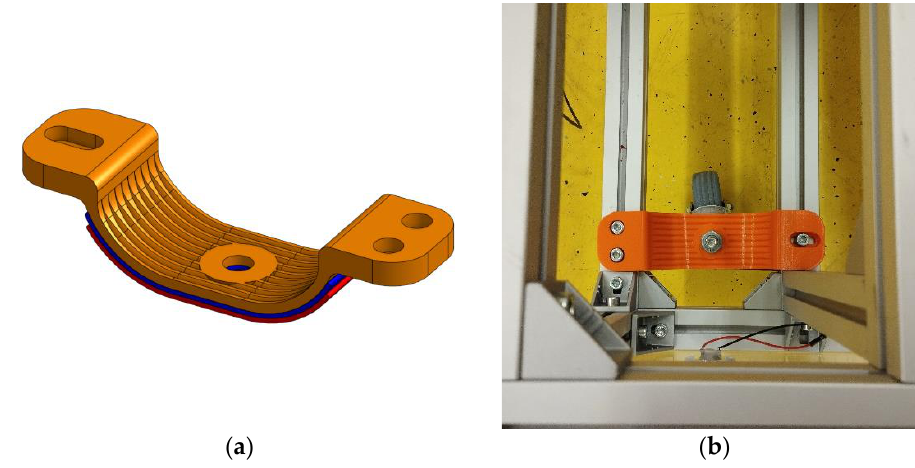
Figure 6. ( a ) Model of the designed spring; ( b ) Spring with wheel screwed to the frame.